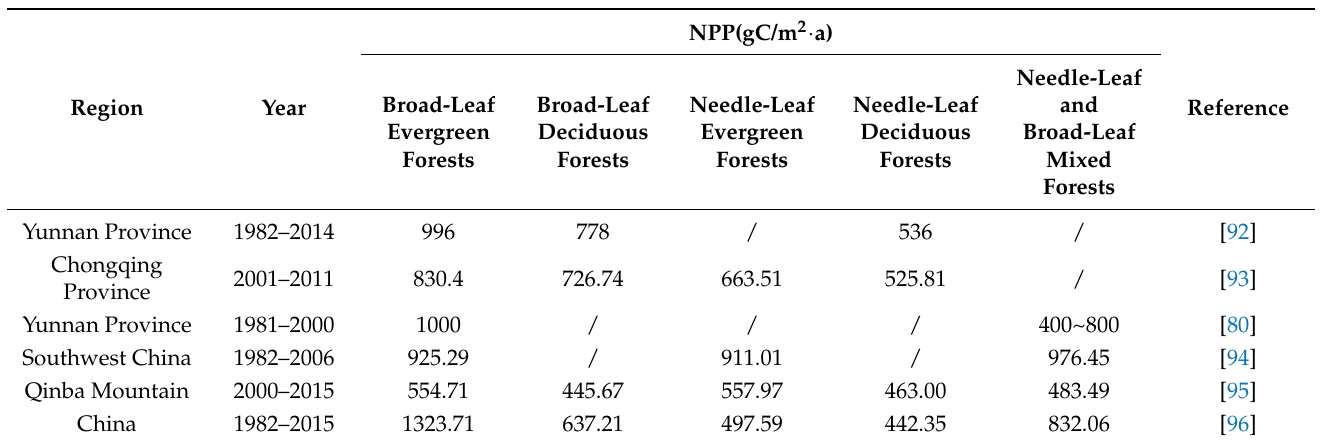
Table 5. Summary of the annual average NPP of different forest vegetation types in Southwest China and China.